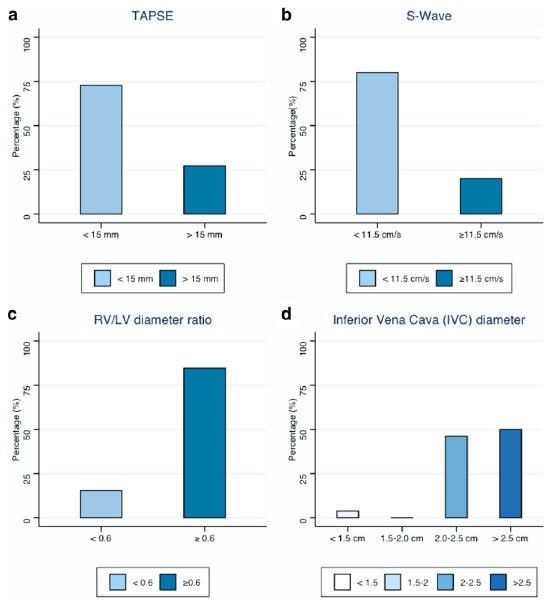
Fig. 1 Echocardiographic right ventricular parameters at